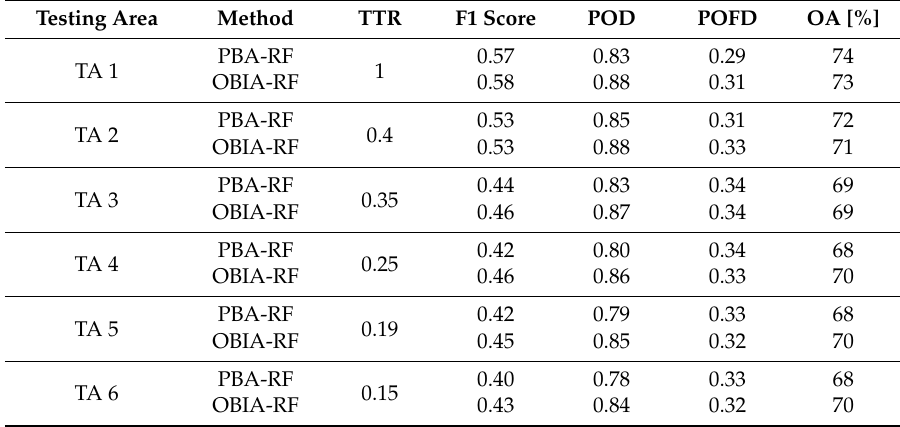
Table 5. Accuracy assessment for training and testing strategy 1 (region growing testing). Testing areas 1–6 abbreviated as TA